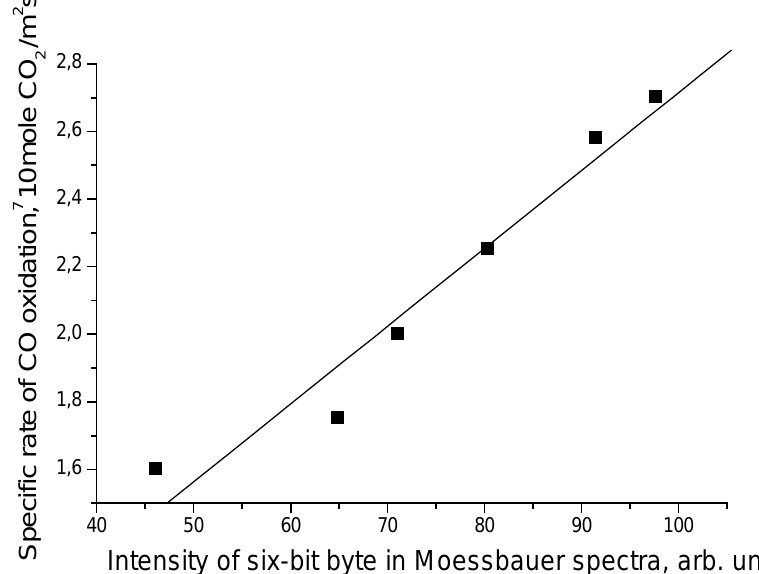
Fig.3 Dependence of the specific rate CO oxidation vs. the concentration of stacking fault measured by Moessbauer spec-